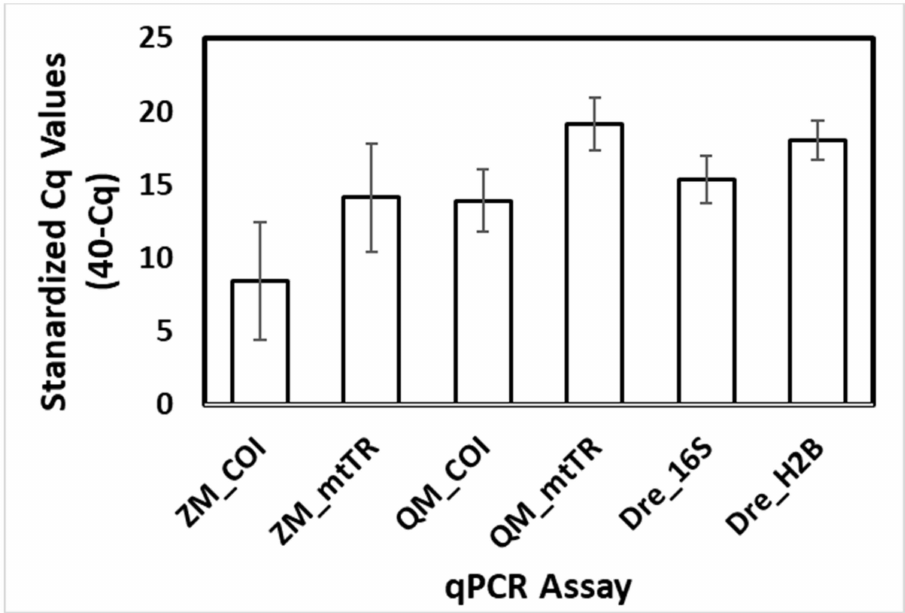
Figure 5. Mean standardized Cq values ( ± standard deviation) for each of the six eDNA assays across all water samples collected from western Lake